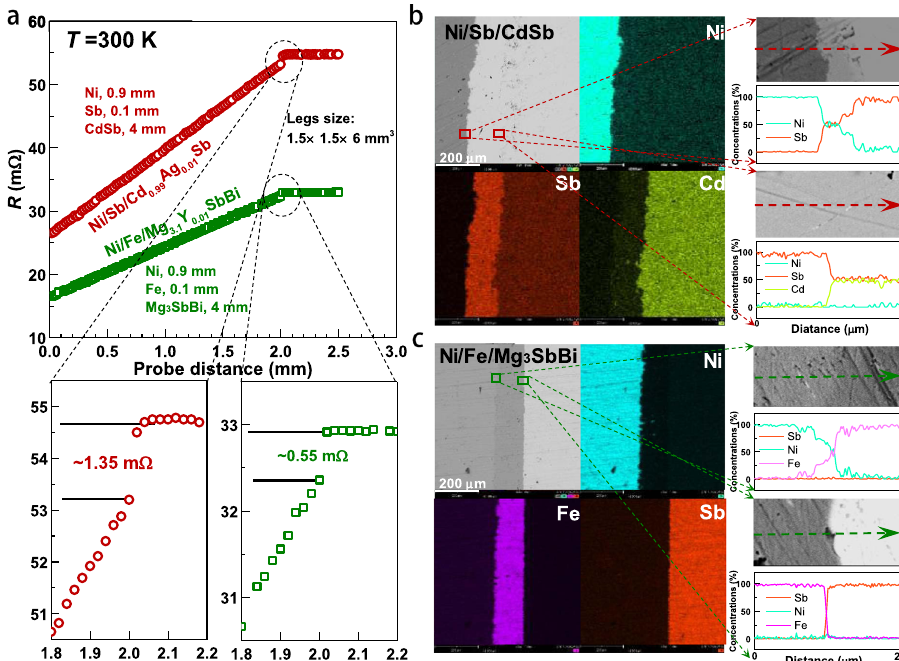
Fig. 4 Contact structure and resistance. Line scanning of resistance ( R ) across the Ni/Sb/CdSb and Ni/Fe/Mg 3 SbBi interfaces for estimating the contact resistance ( a ), SEM images, EDS mapping, and EDS line scanning for the Ni/Sb/CdSb ( b ) and the Ni/Fe/Mg 3 SbBi junctions ( c